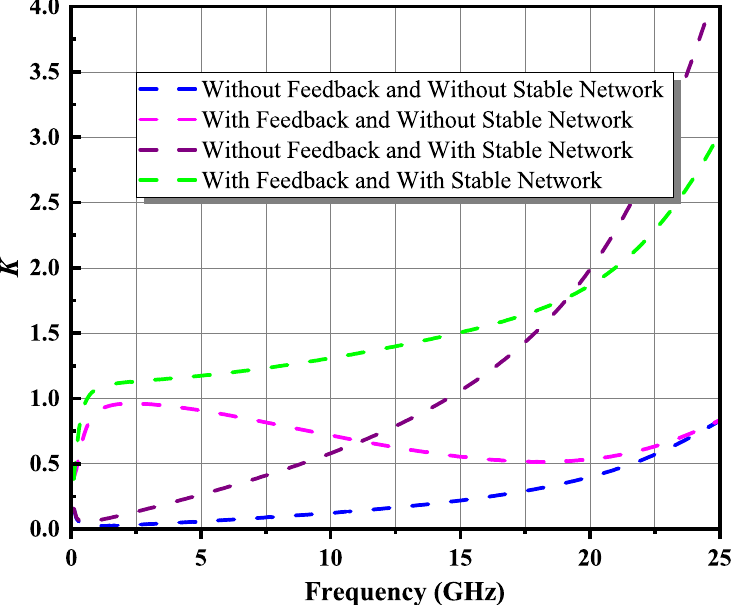
Figure 4. Simulated stability factor K with and without the insertion of feedback and stable